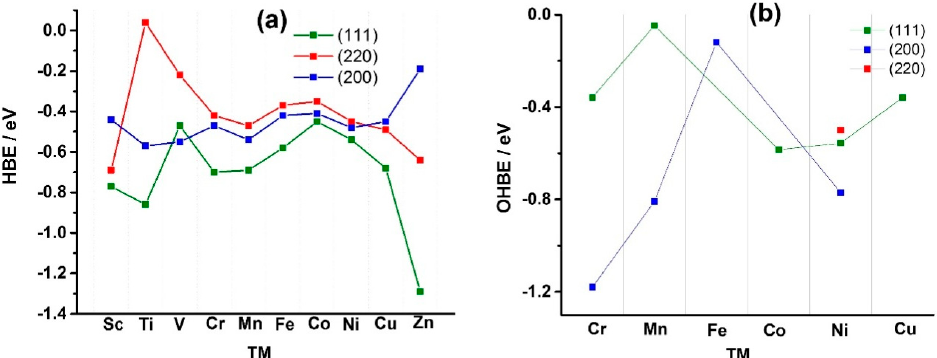
Figure 1. HBE ( a ) and OHBE ( b ) values on different facets for Ni 3 TM 1 alloys presented in the same order as the 3d TMs in the Periodic Table.